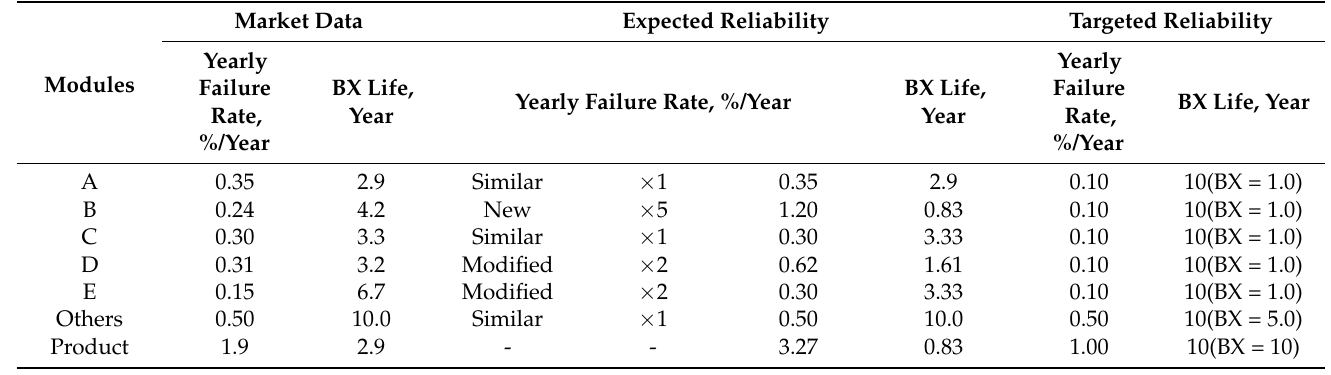
Table 1. Whole ALT plan of mechanical system such as modules in a refrigerator.